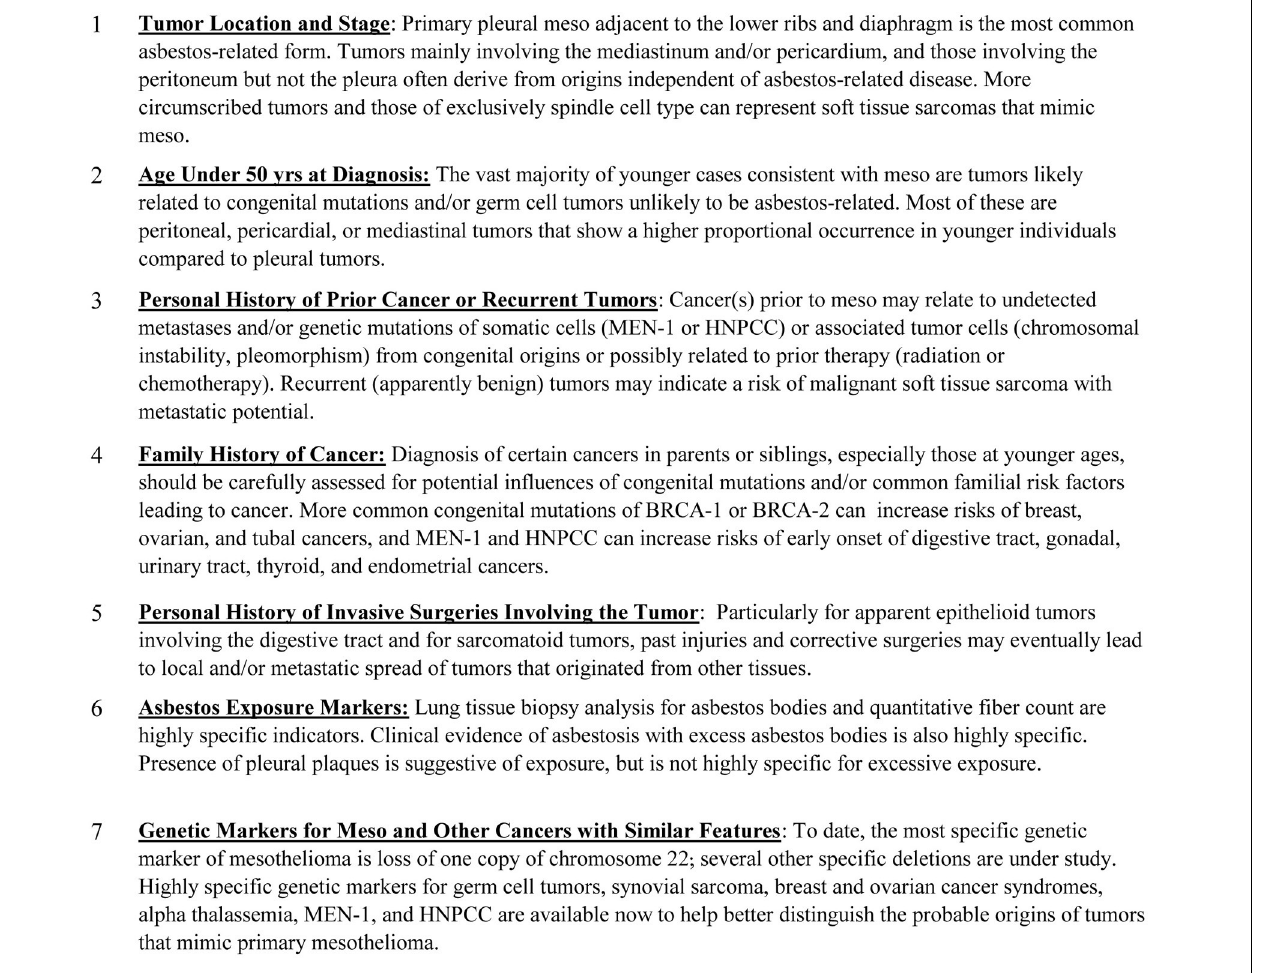
FIGURE 2 | Additional factors to consider in evaluating suspected asbestos-related